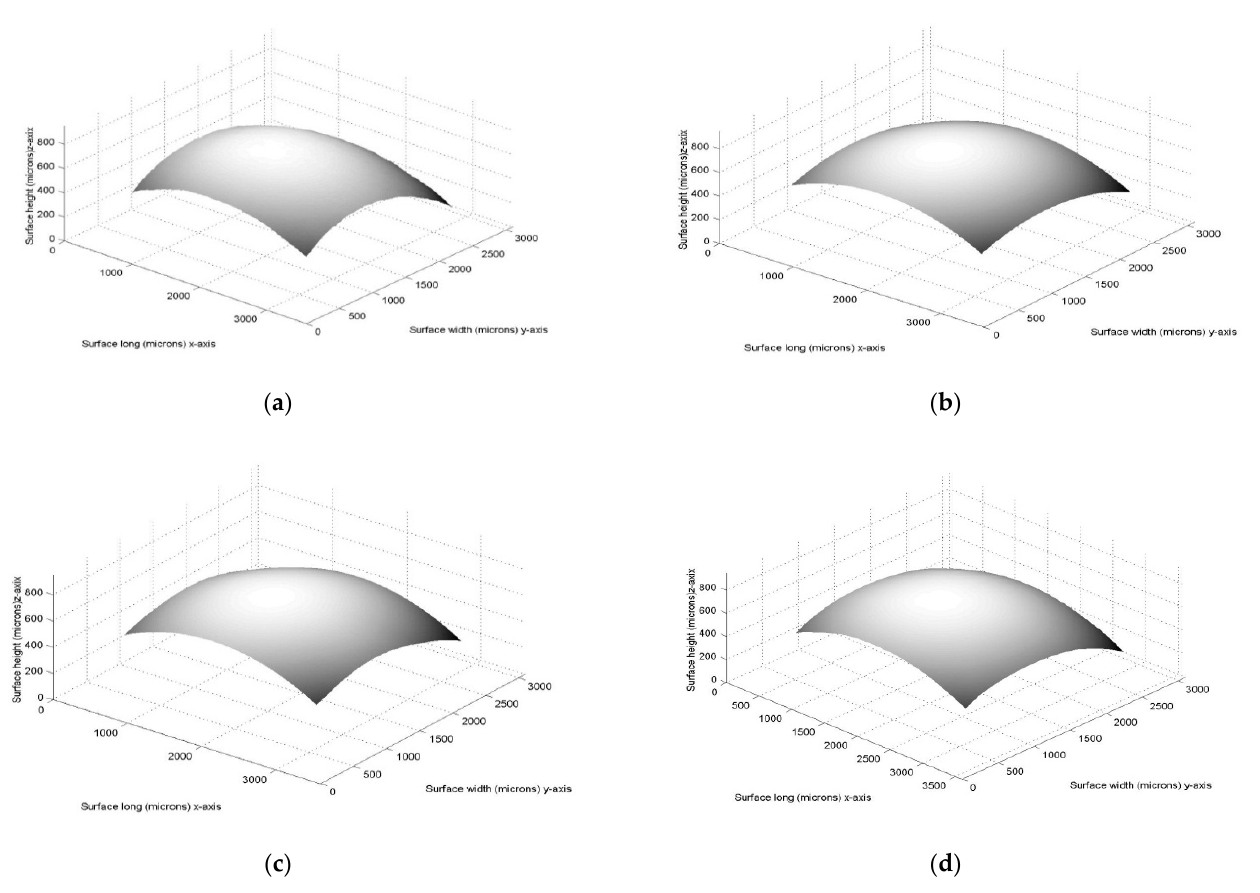
Figure 6. ( a ) Spherical surface retrieved via micro laser line scanning. ( b ) Spherical surface gener- ated via spherical surface model Equation (1). ( c ) Surface generated via spherical surface model Equation (1) and the surface data over the surface model. ( d ) Surface generated via spherical surface model Equation (1) and surface data under the